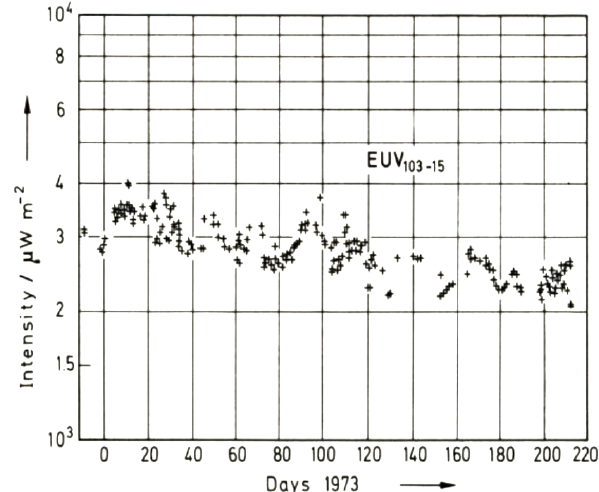
Figure 19. AEROS-A solar EUV flux data between 15 and 103nm (Schmidtke, 1976a; copyright permission granted by Wiley publish- ing).